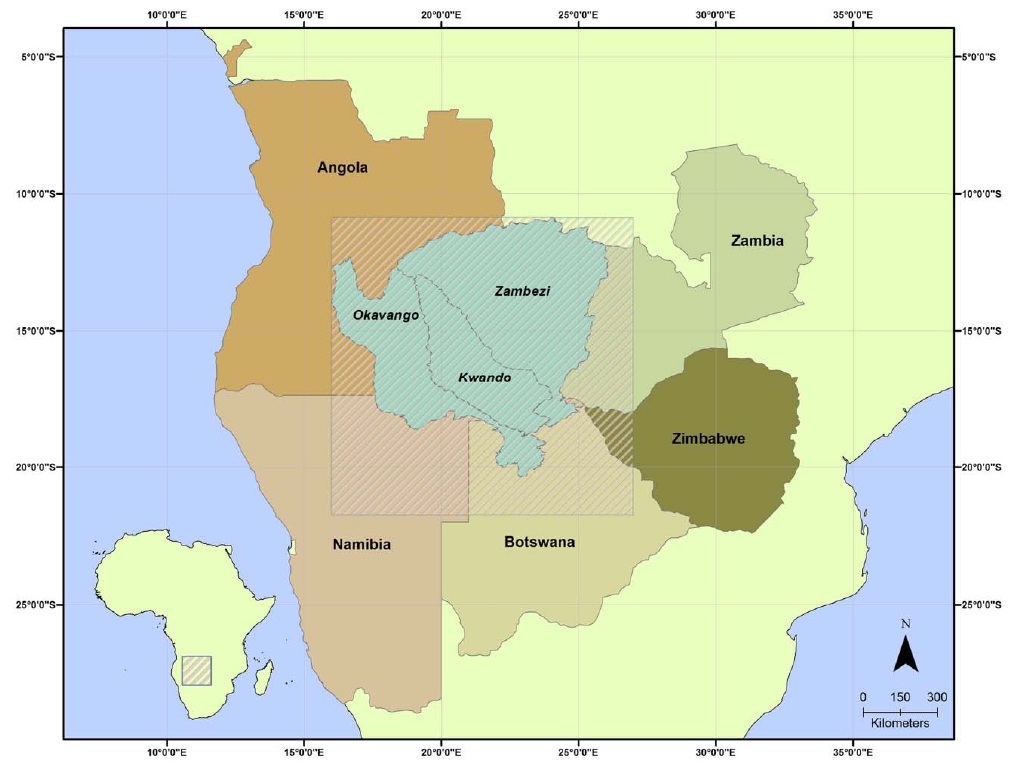
Figure 1. Study area highlighting the countries (Botswana, Namibia, Zambia, Zimbabwe, and Angola) and drainage basins (Okavango, Kwando, and Zambezi) where the research was conducted.